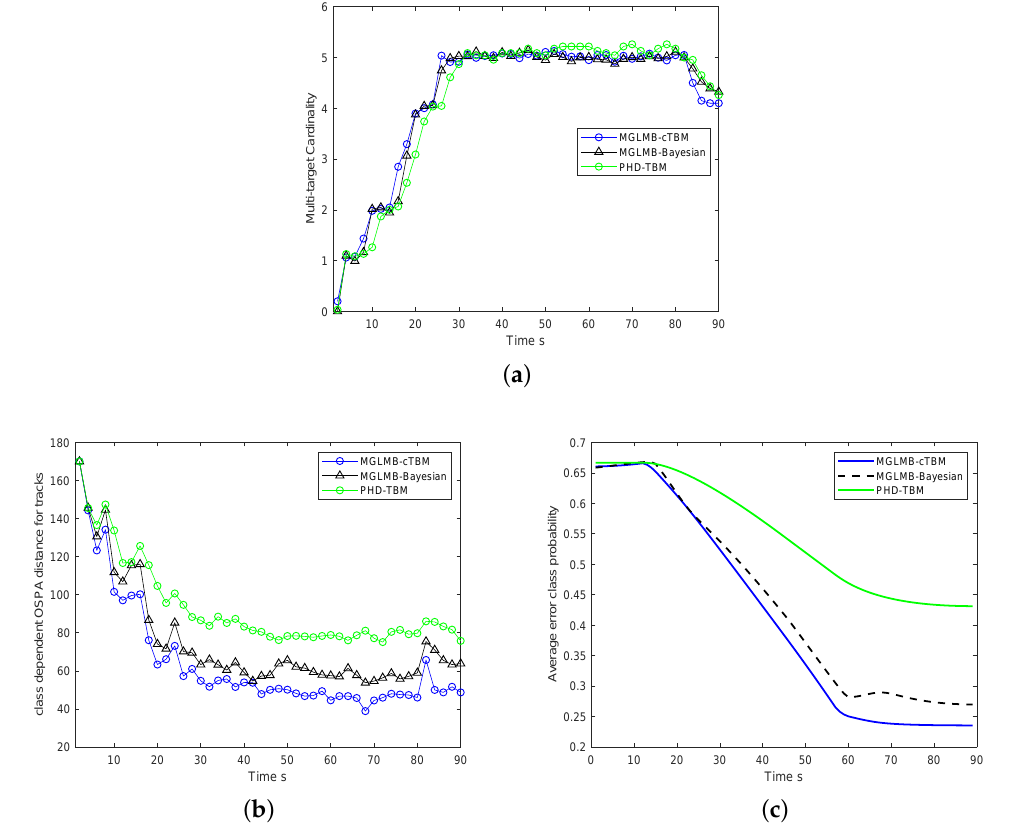
Figure 9. The comparison of tracking and classification results between MGLMB-Bayesian and MGLMB-cTBM; ( a ) cardinality estimates, ( b ) overall tracking performance, ( c ) average error class